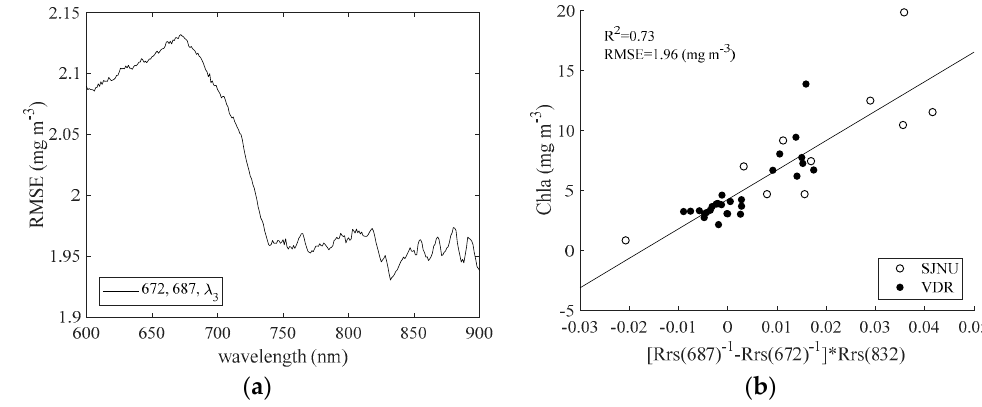
Figure 5. Chlorophyll a (Chla) results of the three-band model (C2) in Lake Shinji and Lake Nakaumi (SJNU) and the Vaal Dam Reservoir (VDR). ( a ) Root mean square error (RMSE) variation between [ R rs − 1 (687) − R rs − 1 (672)] × R( λ 3 ) and measured Chla when λ 3 is in the 600–900-nm range; ( b ) optimal correlation between [ R rs − 1 (687) − R rs − 1 (672)] × R(832) and measured Chla.